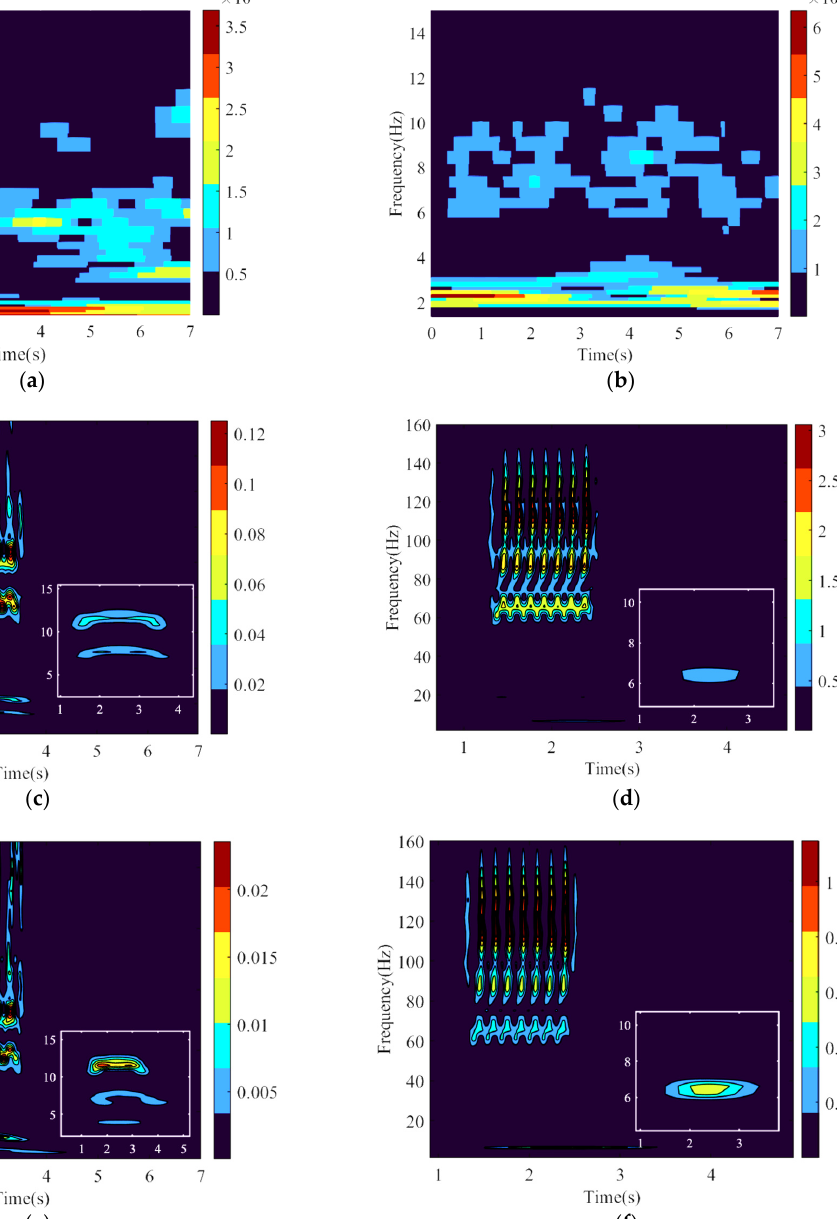
Figure 10. Scalogram for the track and the car body vertical vibratory resonant acceleration response: ( a ) First car body response scalogram under nonresonant bridge; ( b ) First car body response scalogram under resonant bridge; ( c ) Mid–rail response scalogram under nonresonant bridge; ( d )